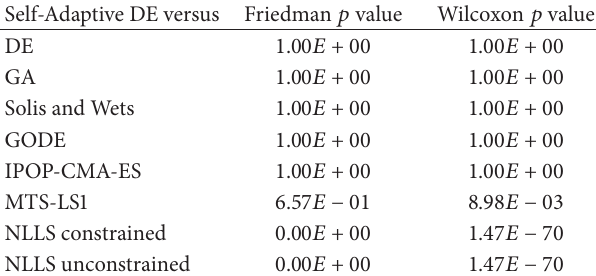
Table 4: Corrected 𝑝 values according to Holm’s method (Self- Adaptive DE is the control algorithm) for the glutamate concentra- tion ̂𝑅 2 = 0.990 .